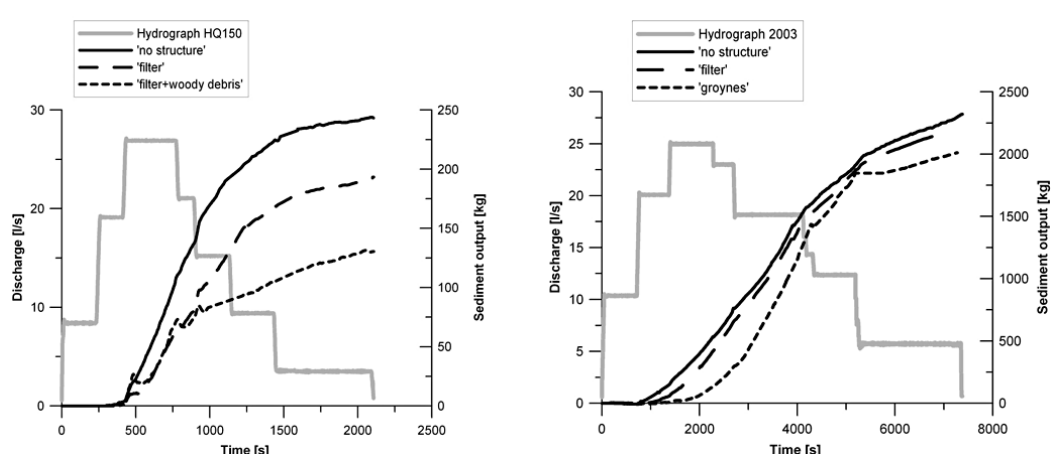
Fig. 6. Continuous cumulative output rate of bedload from the topmost section of the planned deposition area: test cases “no structure”, “filter”, and “filter + woody debris” for Scenario 1 (left), and test case “filter”, “groynes” and “no structure” for Scenario 3